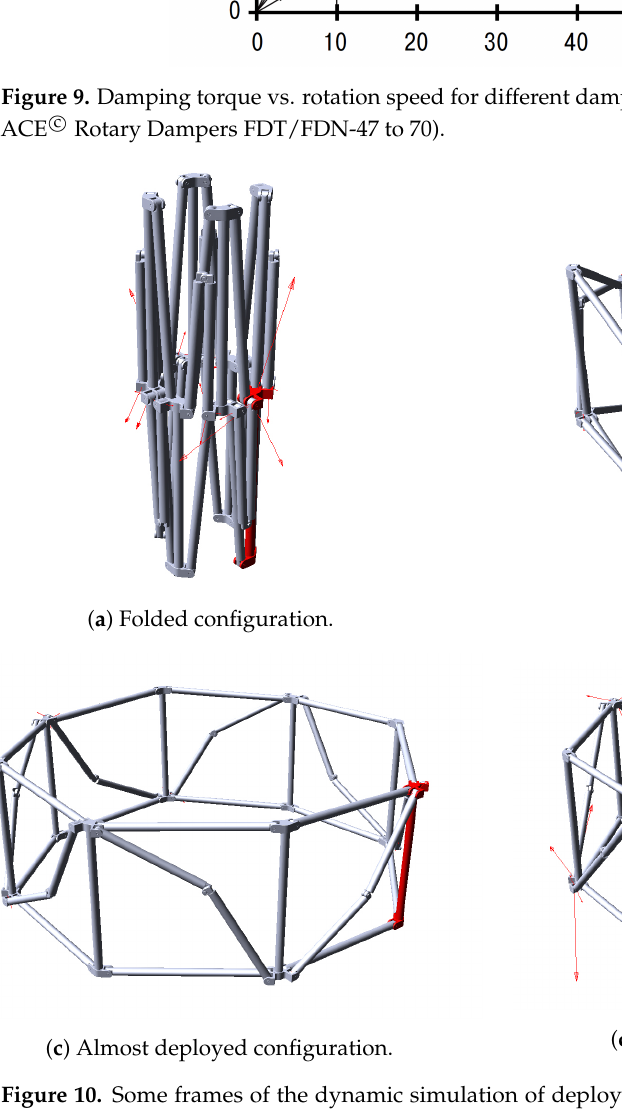
Figure 10. Some frames of the dynamic simulation of deployment of the real system, of which the sequence follows the alphabetical